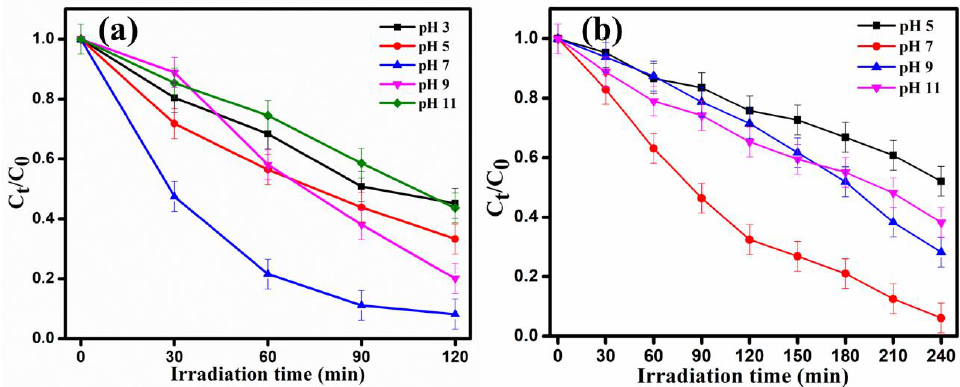
Figure 9. Impact of pH of solution on photodegradation efficiency ( a ) NP (Conc. 4 × 10 −4 M) and ( b ) BPA (Conc. 2 × 10 −4 M) pollutants over CLMO catalyst (20 mg/100 mL).